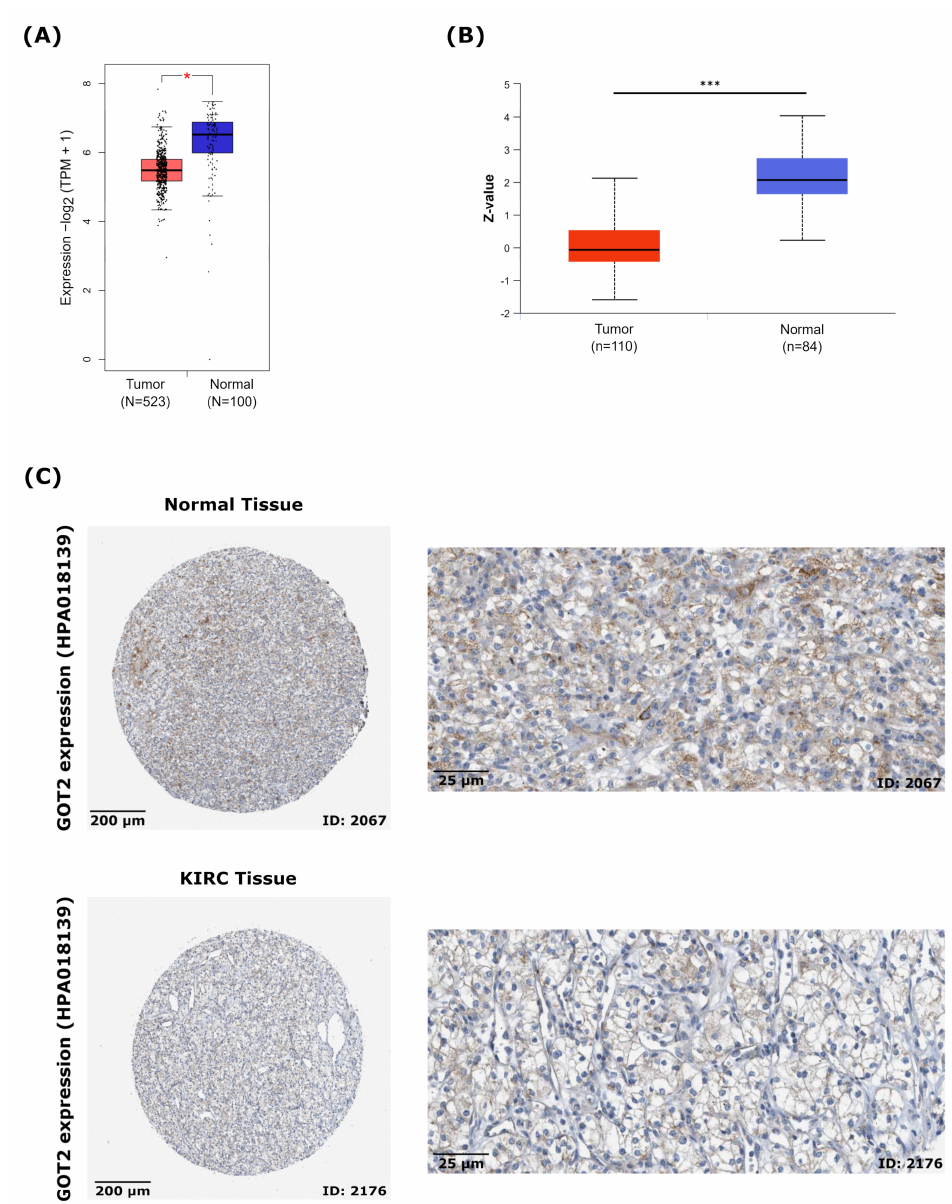
Figure 2. Expression of GOT2 in KIRC and normal patients. ( A ) Differential expression of GOT2 between KIRC samples from TCGA database (Red, n = 523 samples) and normal human kidney samples from GTEx database (Blue, n = 100 samples). (* p < 0.05, *** p < 0.001) ( B ) Significant downregulation of GOT2 protein level in the CPTAC KIRC cohort, analyzed by UALCAN. KIRC: n = 110; Normal samples: n = 84. Z-values represent standard deviations from the median across samples. ( C ) Representative images of immunohistochemical (IHC) staining of GOT2 protein in normal kidney tissue (Patient ID: 2067; Staining: medium; Intensity: moderate; Quantity: 75–25%; Location: cytoplasmic/membranous) and KIRC tissue (Patient ID: 2176; Staining: low; Intensity: weak; Quantity: >75%; Location: cytoplasmic/membranous) from the HPA database. Scale bars: left, 100 µ m; right, 25 µ m. Antibody used in both samples: